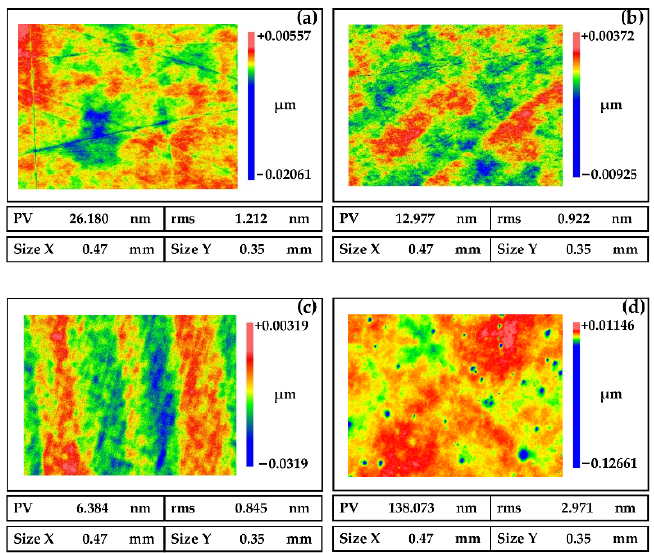
Figure 6. Polished surfaces of NiP coating induced by oxidants of different concentrations ( a ) 0 wt%, ( b ) 5 wt%, ( c ) 10 wt%, and ( d ) 15 wt%. ( b ) 5 wt%, ( c ) 10 wt%, and ( d ) 15 wt%.